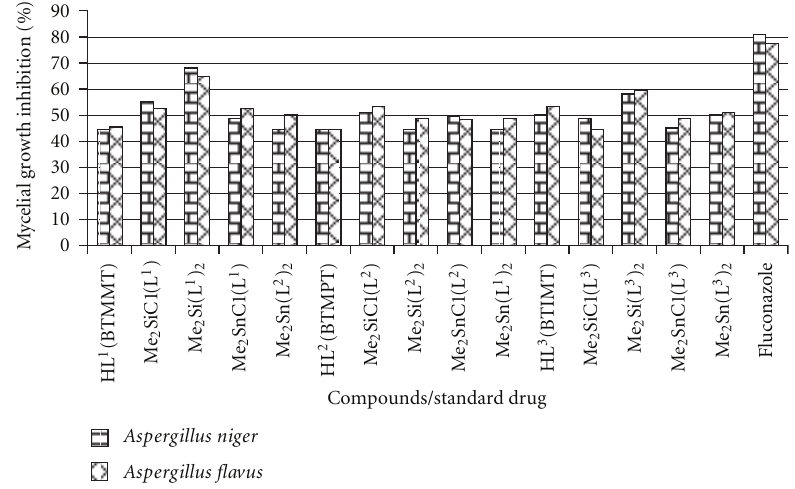
Figure 5: Comparison of antifungal activity of compounds with commercial